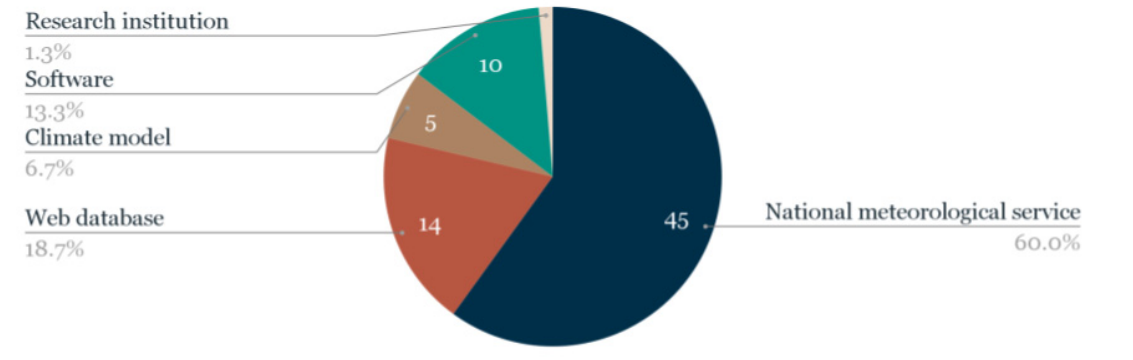
Figure 7. The most common climate data sources.